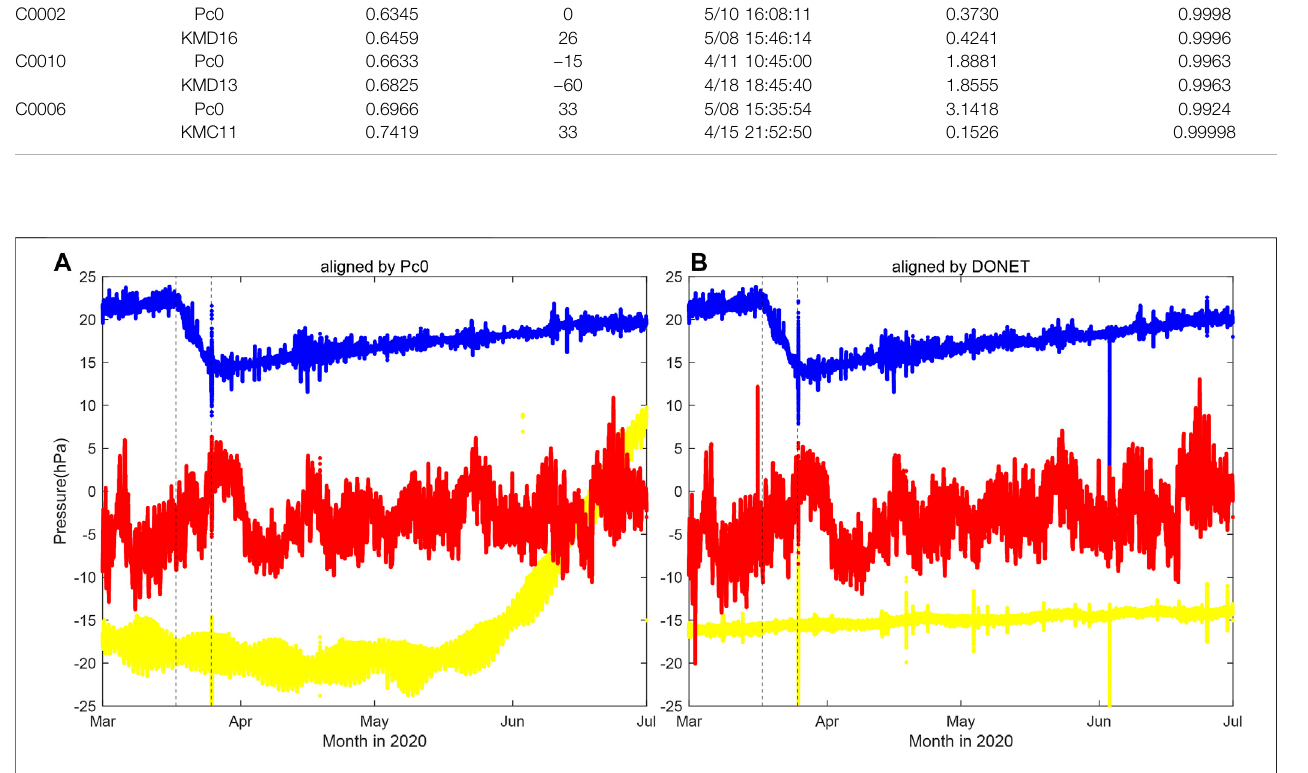
Frontiers in Earth Science |